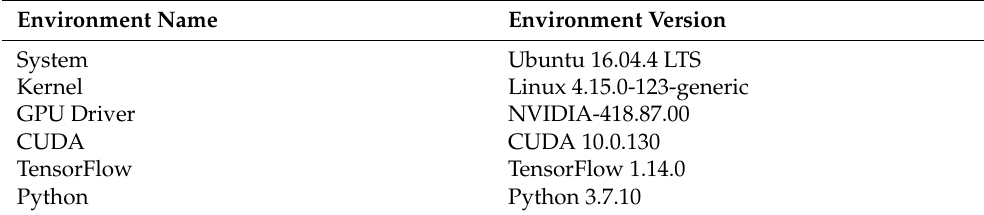
Table 4. Experimental software environment.